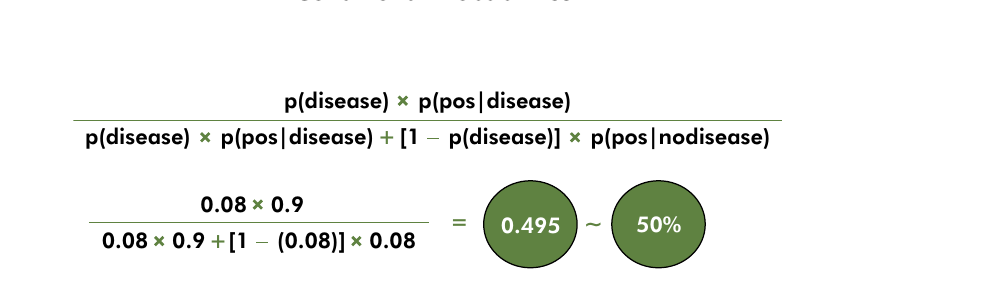
Figura 3. In the formula of probabilities, the proportion of adults with interproximal caries in the population is 8%, the proportion of positives with interproximal caries is 90% and the proportion of positives without interproximal caries is 7.6% ≈ 8%. Adapted from Nadanovsky et al. 10 with